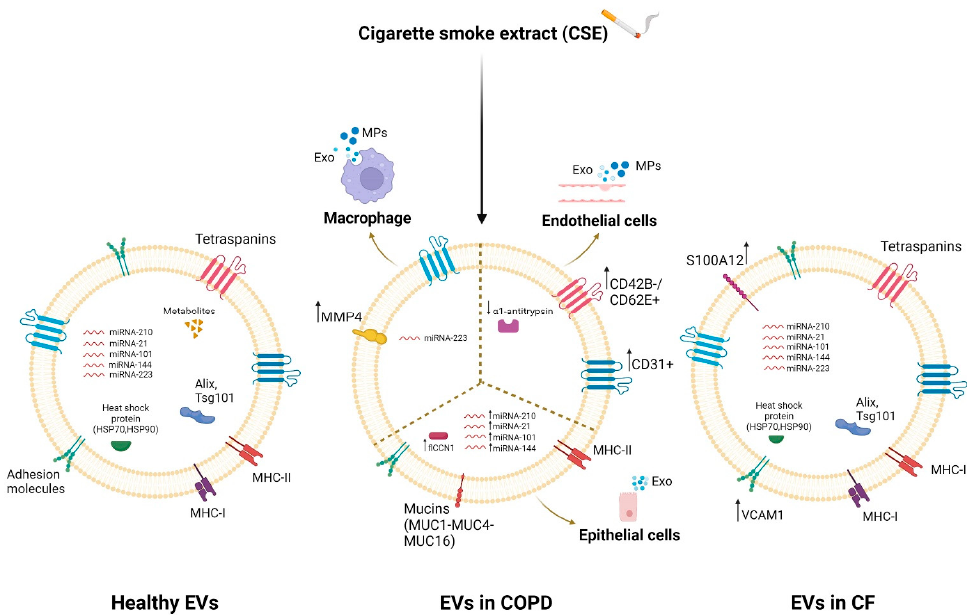
Figure 1. Molecular cargo of healthy EVs and vesicles released by various cell types in the pathogen- esis of chronic obstructive pulmonary disease (EVs in COPD) and cystic fibrosis (EVs in CF). The increase in some vesicle’s components, involved in certain respiratory diseases, is indicated by an upward arrow. The exposure to various stimuli such as cigarette smoke extract leads to changes in the content of EVs released by the various cell types in the lung. In COPD, MMP4 and miRNA-223 levels increase in the vesicles released by macrophages; epithelial-cell-derived EVs show an overexpression of miRNA-101, miRNA-21, miRNA-210, miRNA-144 and an increase in the cellular communication network factor 1 (flCCN1) levels; endothelial cells secrete exosomes and microparticles (MPs) rich in CD31+/CD42b- or CD31+/CD62E+ and with reduced levels of α 1-antitrypsin. In CF, the expression of the integrin protein VCAM1 and the ligand S100A12 is enhanced in the EVs released by the airway bronchial epithelial cells. Created with BioRender.com.